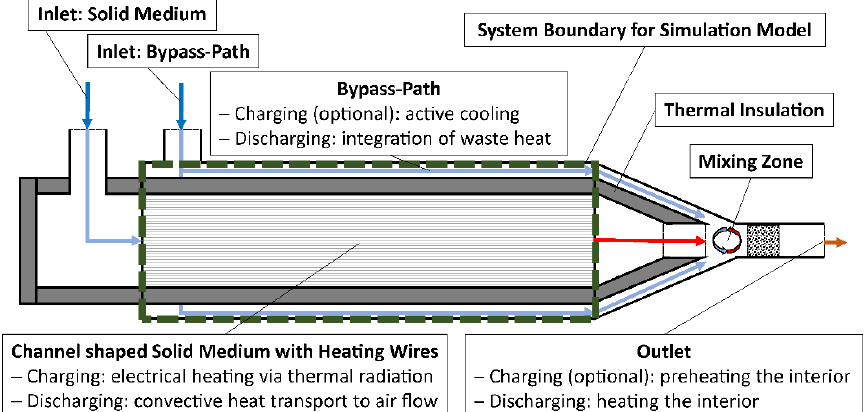
Figure 1. Schematic representation of the favorite thermal storage concept